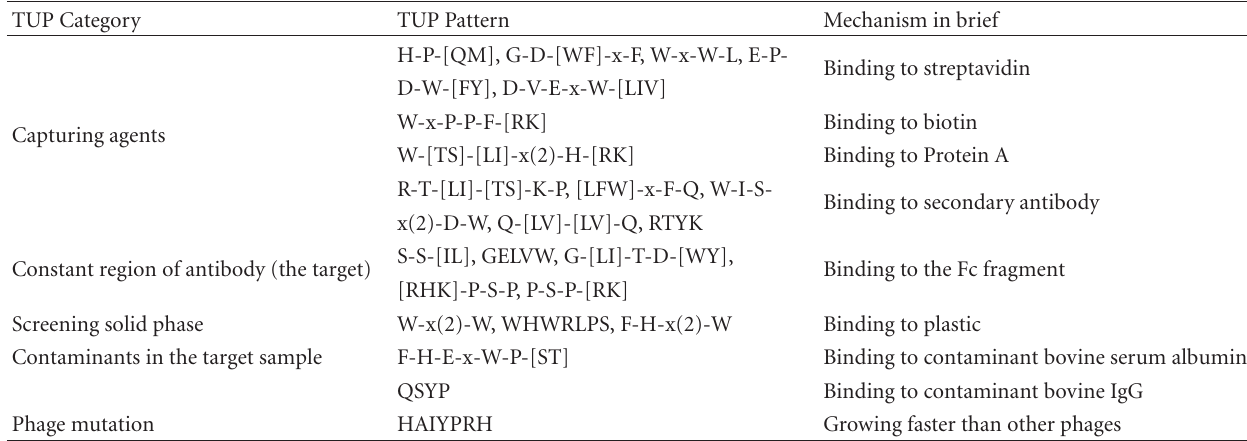
Table 1: Known patterns of target-unrelated peptides.